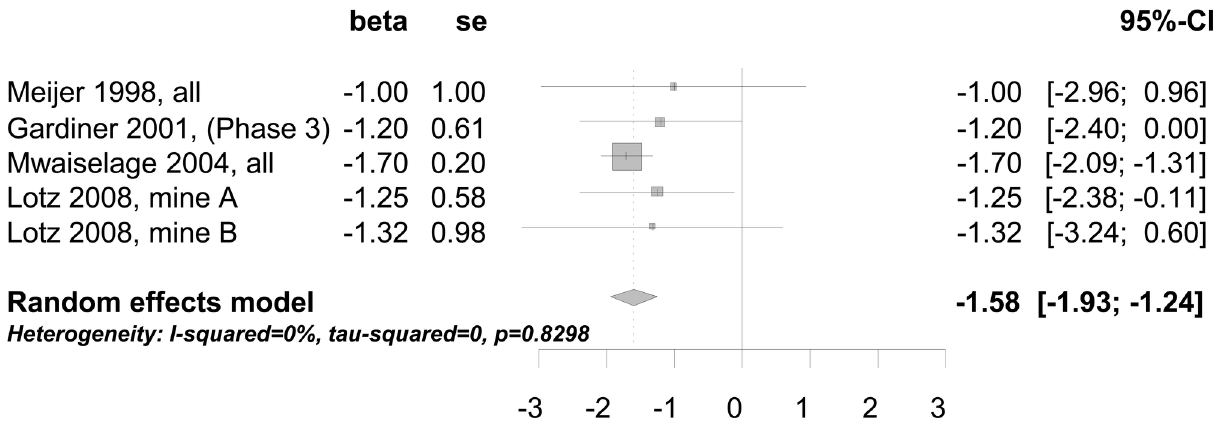
Figure 5. Decrease of FEV1 (ml) in relation to the cumulative exposure to bg dust at the workplace (mg·m -3 ·years).